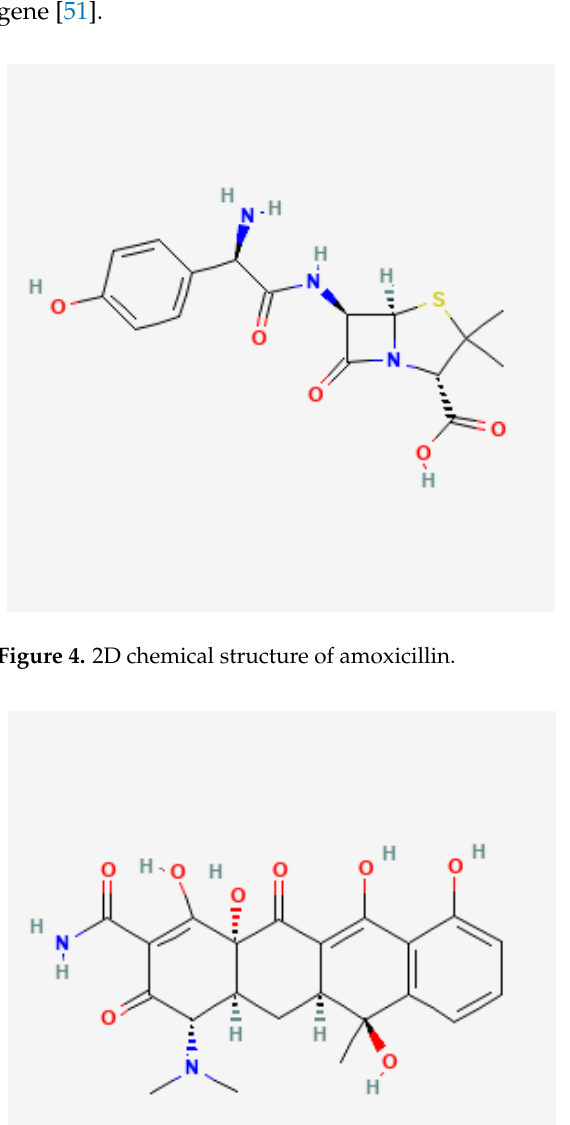
Figure 4. 2D chemical structure of amoxicillin.